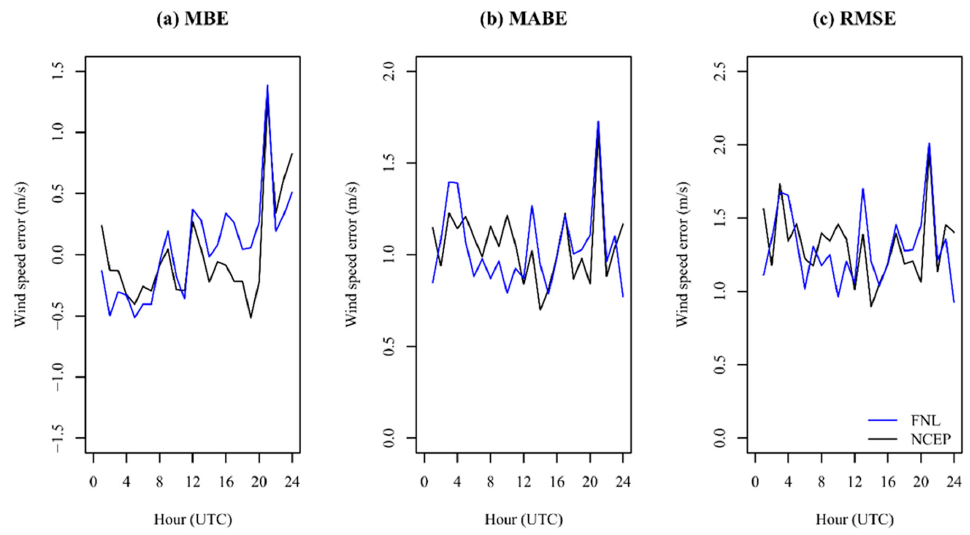
Figure 8. 10 m level wind speed error variations by hour for April 2003 for Piarco.